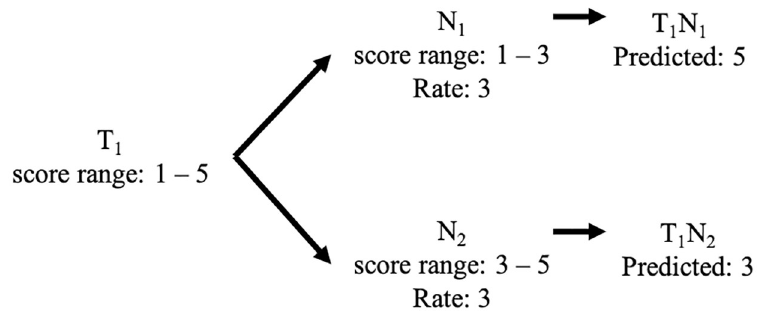
Fig 4. Example of rating conversion